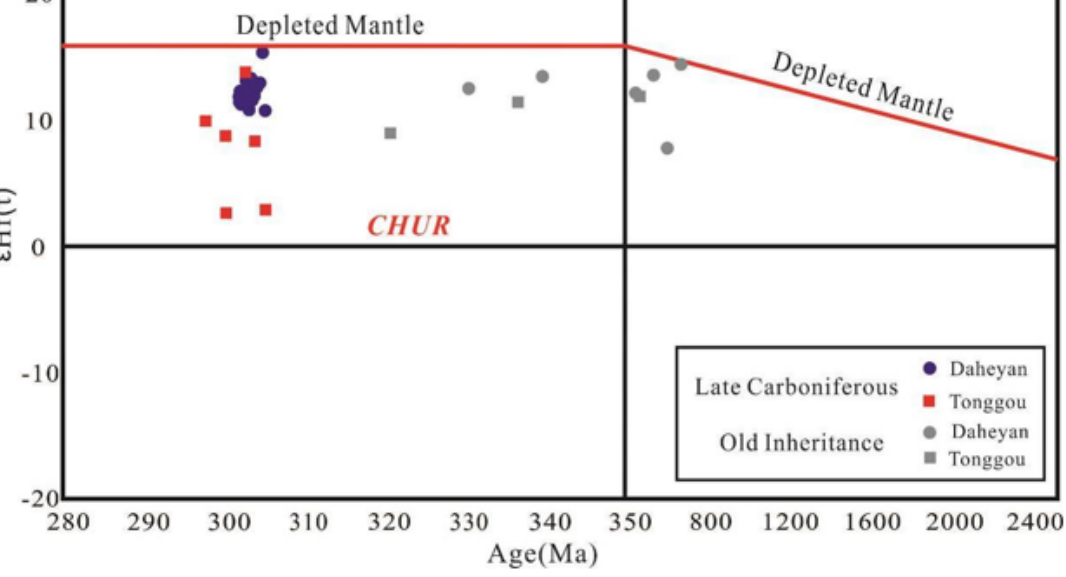
Figure 9. Zircon U-Pb ages vs. ε Hf(t) plots for Tonggou and Daheyan samples. Partial data for Daheyan granodiorite cited from